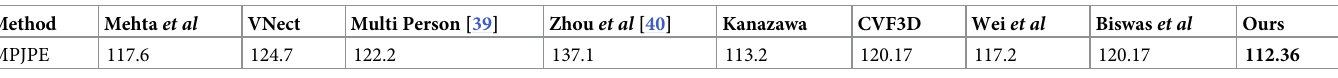
Table 6. Comparison of our method and multiple mainstream 3D pose estimation models in MPI-INF-3DHP. The better results are written in bold, they include multi-view models. Method Mehta et al